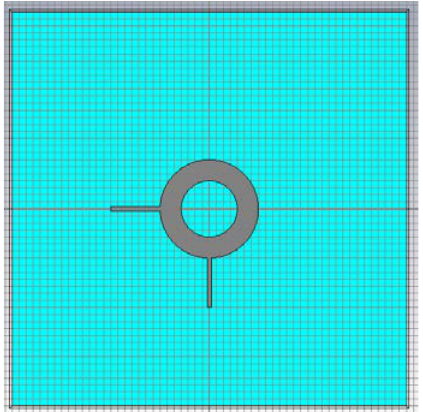
Figure 6: Top view of the microstrip circular resonator.